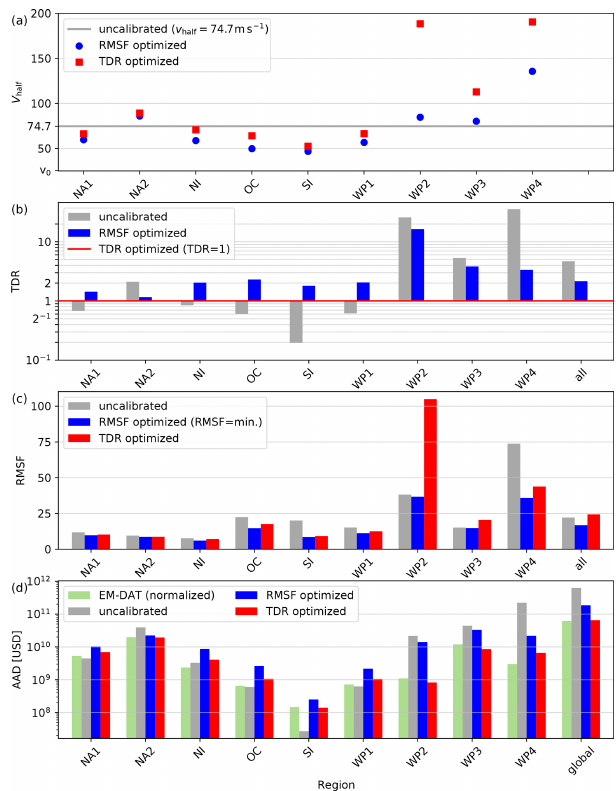
Figure 6. Calibration results and cost functions for nine calibration regions and all regions combined, each shown before (gray) and after (blue and red) calibration: (a) V half : fitted impact function pa- rameter; (b) TDR: ratio of total simulated and normalized reported damage; (c) RMSF: root-mean-squared fraction; and (d) AAD: nor- malized reported (green) and simulated annual average damage (AAD). AAD is computed from all events available in EM-DAT ( N = 1650, green) and IBTrACS ( N = 4098) and not just the 473 matched events used for calibration (a–c) . Please refer to Tables 1 and A2 for numerical values. The regions are the Caribbean with Central America and Mexico (NA1), the USA and Canada (NA2), North Indian Ocean (NI), Oceania with Australia (OC), South In- dian Ocean (SI), South East Asia (WP1), the Philippines (WP2), mainland China (WP3), and the rest of the north West Pacific Ocean